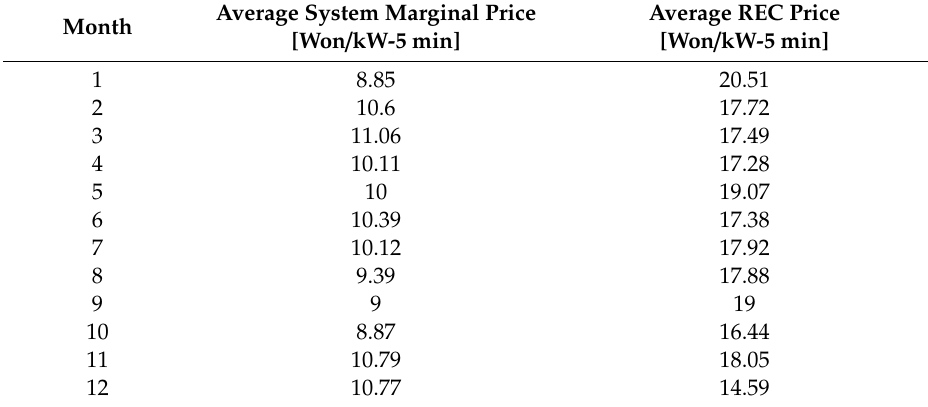
Table 3. Monthly average system marginal price (SMP) and REC price data.